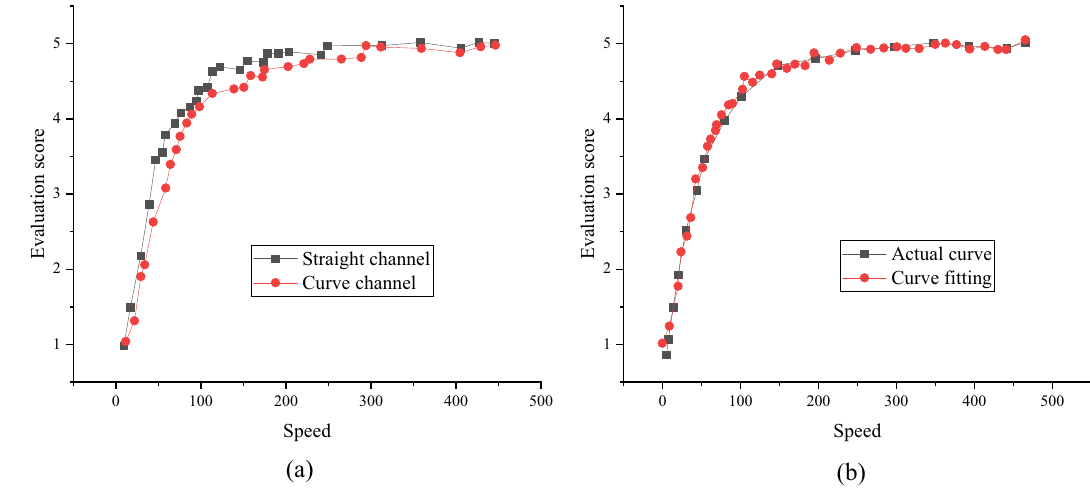
Fig. 6 Dizziness in the horizontal rotation motion scene ( a comparison results in the scenes of the linear channel and curve channel; b curve fitting results)